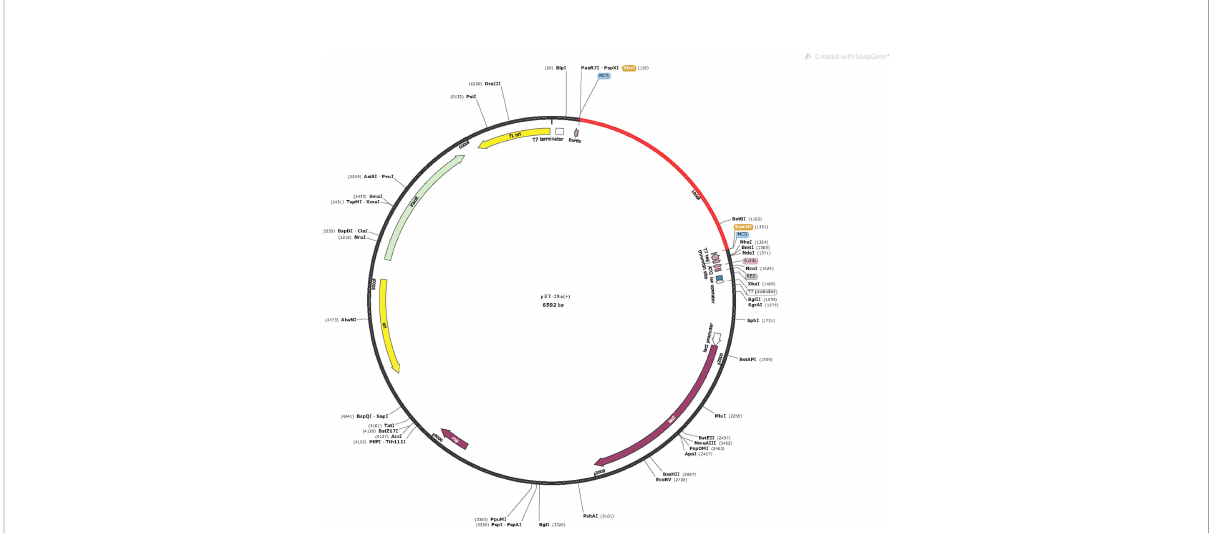
FIGURE 10 In silico cloning of the vaccine in the pET28a(+). Red areas represent the optimized nucleotide sequence of the vaccine, the black areas represent the expression vector, pET28a(+), the XhoI and BamHI represent the cleavage sites of the restriction